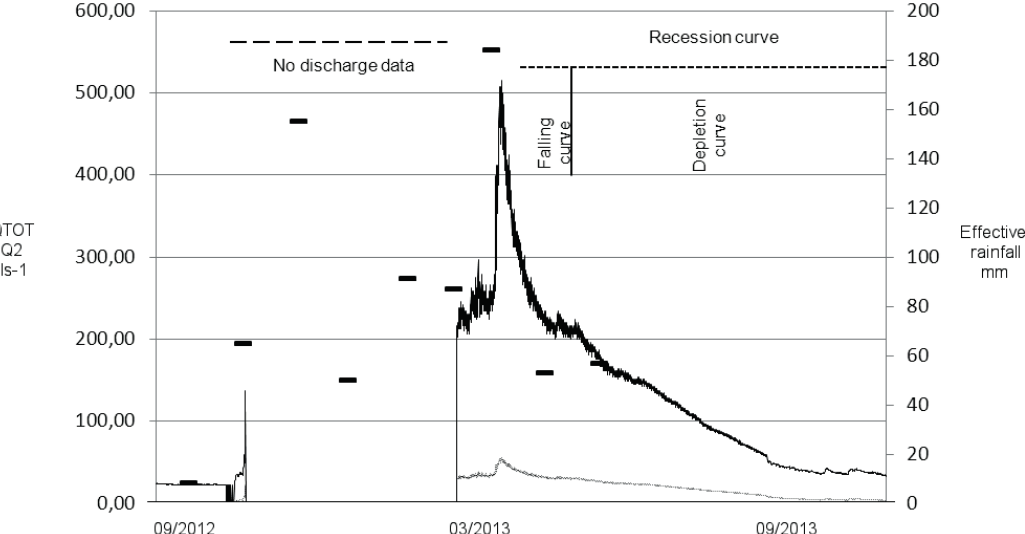
Fig. 3 Estimated QTOT (continuous black line; Ls -1 ) and observed Q 2 (grey dashed line; Ls -1 ) discharges from the hydrologic year 2012–2013 are reported together with monthly effective rainfall (black dashes; in mm). From 2 November 2012 to 11 March 2013 the electric transducer installed in spring S2 was out of work, therefore no discharge data are available for that